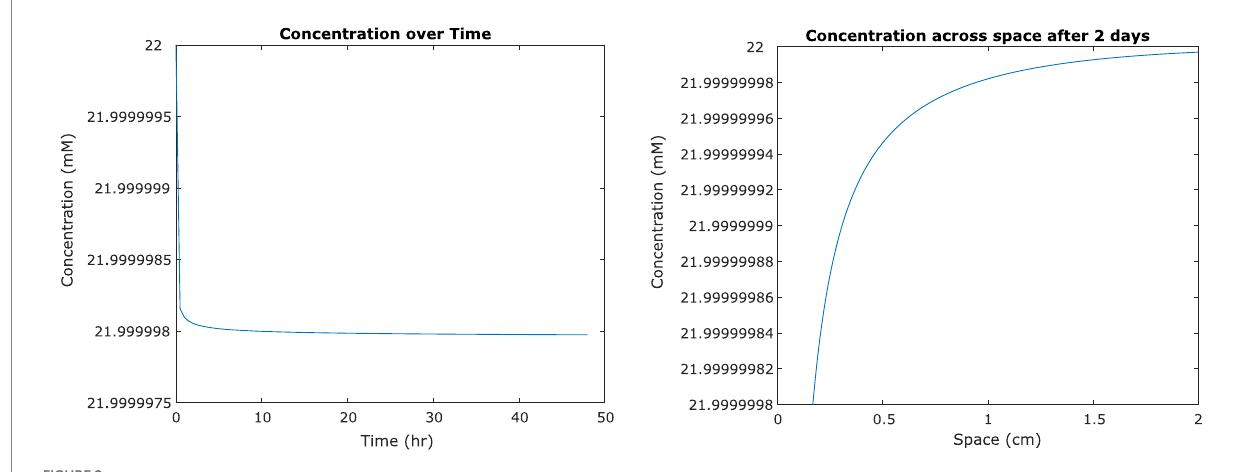
FIGURE 2 (Left) Concentration of glucose in medium at a distance of 0.2 mm from the center of a single Escherichia coli cell, as it changes over time. (Right) Concentration of glucose surrounding that cell at steady state, 2 days from initiation.